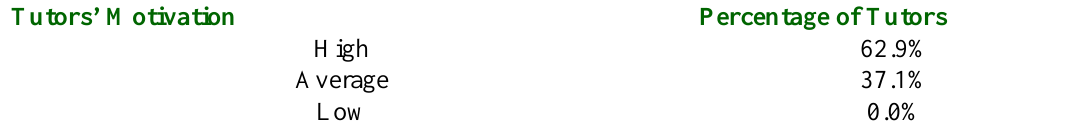
Table 13. Tutors’ self-reported motivation in participating in Web-based English education